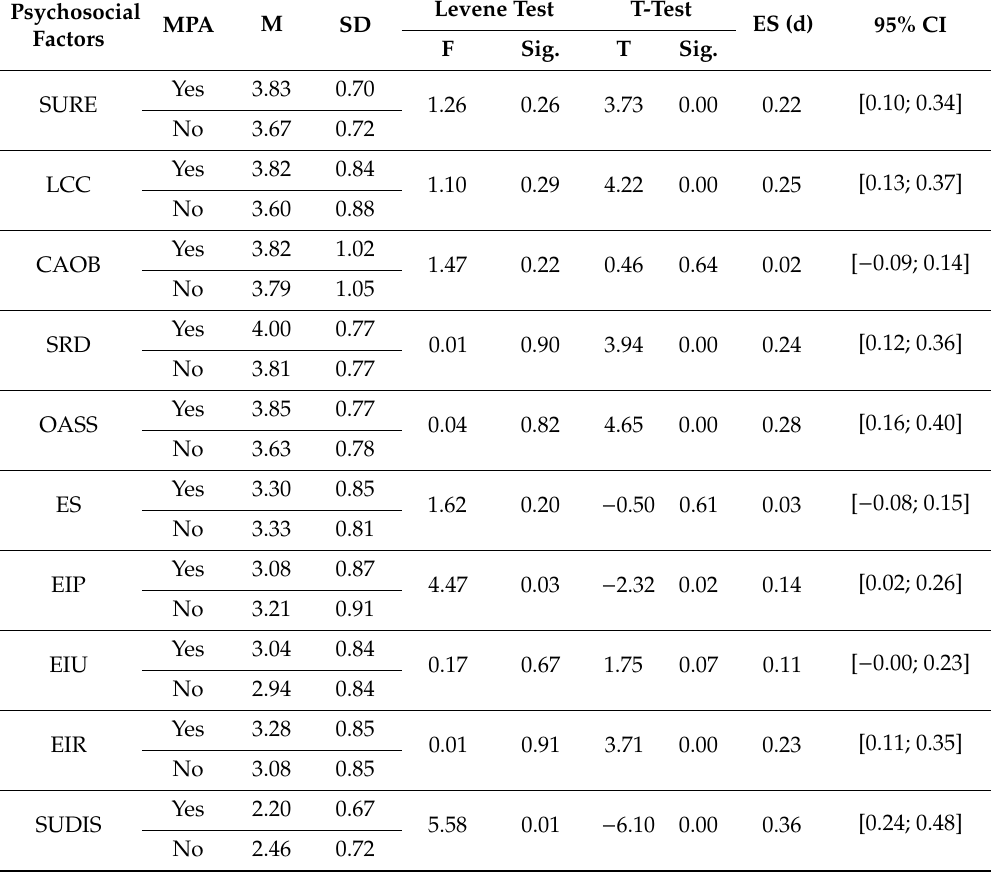
Table 1. Relationships between the dimensions of resilience, emotional intelligence and psychological distress, as a function of physical activity (MPA) adequacy defined according to physical activity guidelines.